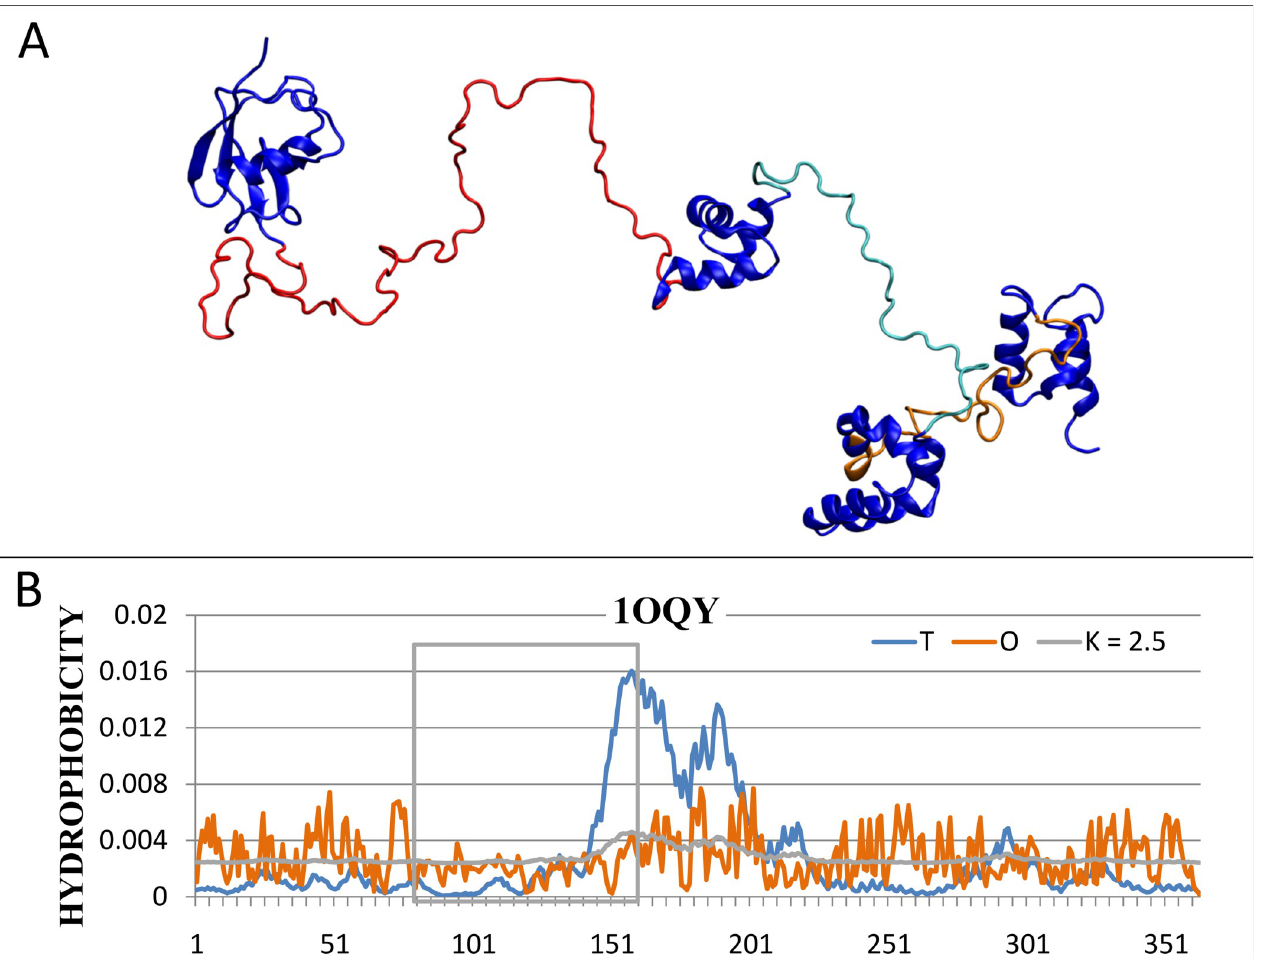
Fig 3. DNA repair protein hHR23a (PDB ID 1OQY). A– 3D structure with IDR (marked as red. B–the distributions T , O and M for K = 2.5 (marked in blue, orange and gray, respectively), IDR denoted by a